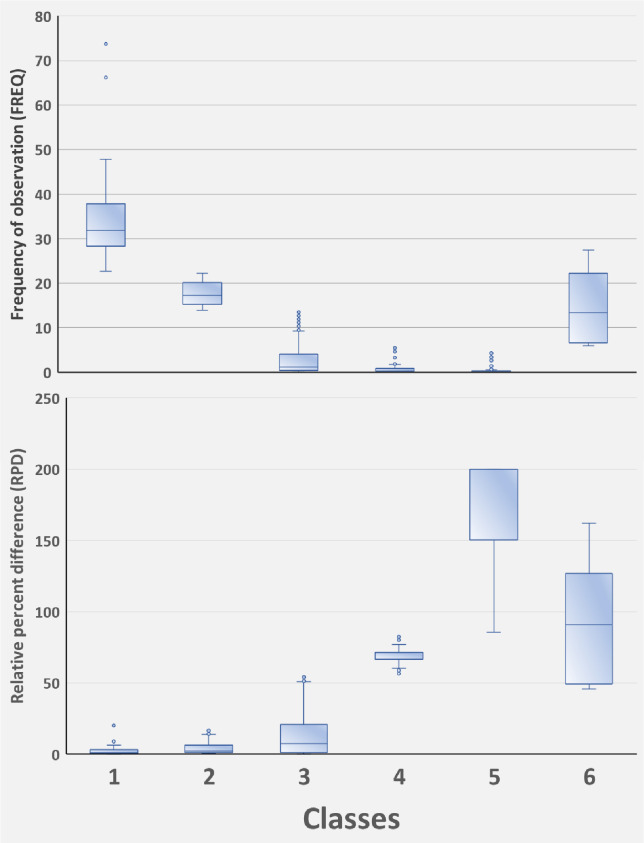
Percentile distributions (boxplots) for frequency of taxon occurrence (FREQ) and relative percent difference (RPD) among the uncertainty-frequency classes.FREQ is the percentage of samples for which a taxon was observed; RPD is a measure of uncertainty associated with taxonomic identifications, thus lower values equate to increased confidence. 1, high confidence, common; 2, high confidence, moderately common; 3, high confidence, rare; 4, moderate confidence, rare; 5, low confidence, rare; 6, outliers, mixed.